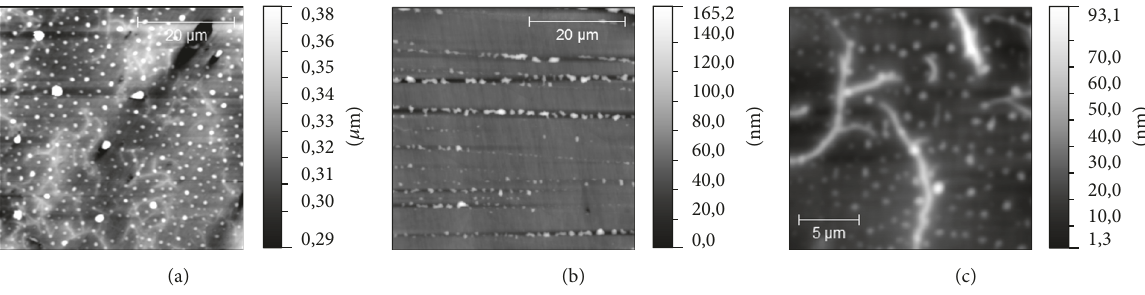
Figure 3: Topography of glasses: (a) S2, (b) S3, and (c) S4.